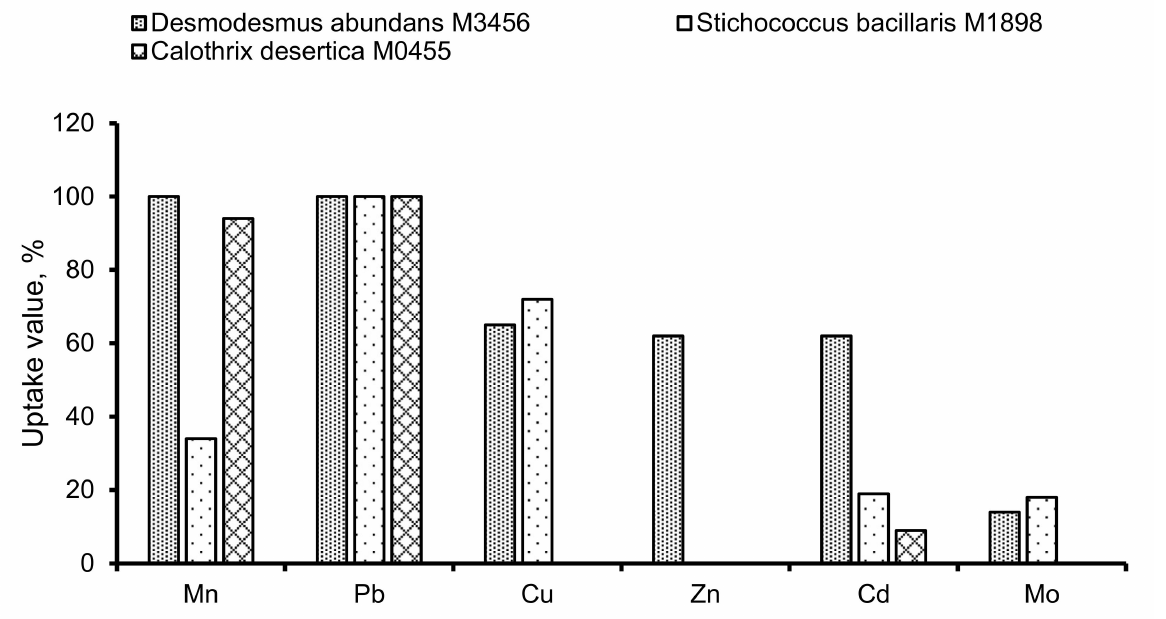
Figure 6. Values of uptake of HMs from supernatant for diverse strains.